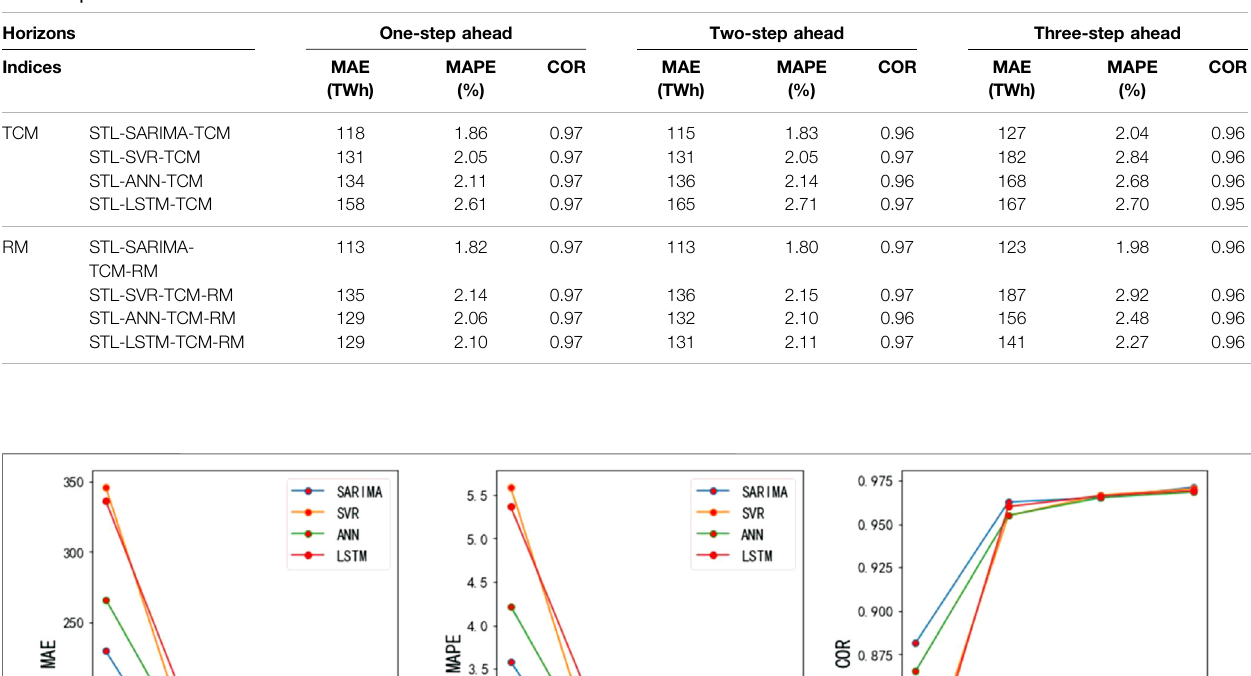
TABLE 2 | Performance evaluations of different models with time correlation modi fi cation and residual modi fi cation.